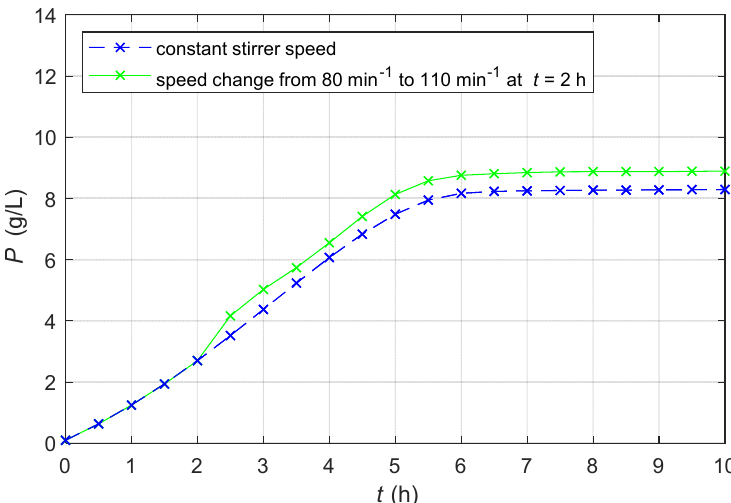
Figure 3. Time courses of product concentrations of the analysed fermentation process in a batch bioreactor with constant stirrer speed n = 80 min − 1 and in a batch bioreactor with step change of stirrer speed from n = 80 min − 1 to n = 110 min − 1 at t = 2 h, obtained with the supplemented non-linear / linear mathematical model in Figure 2 with the parameters in Tables 1 and 3.